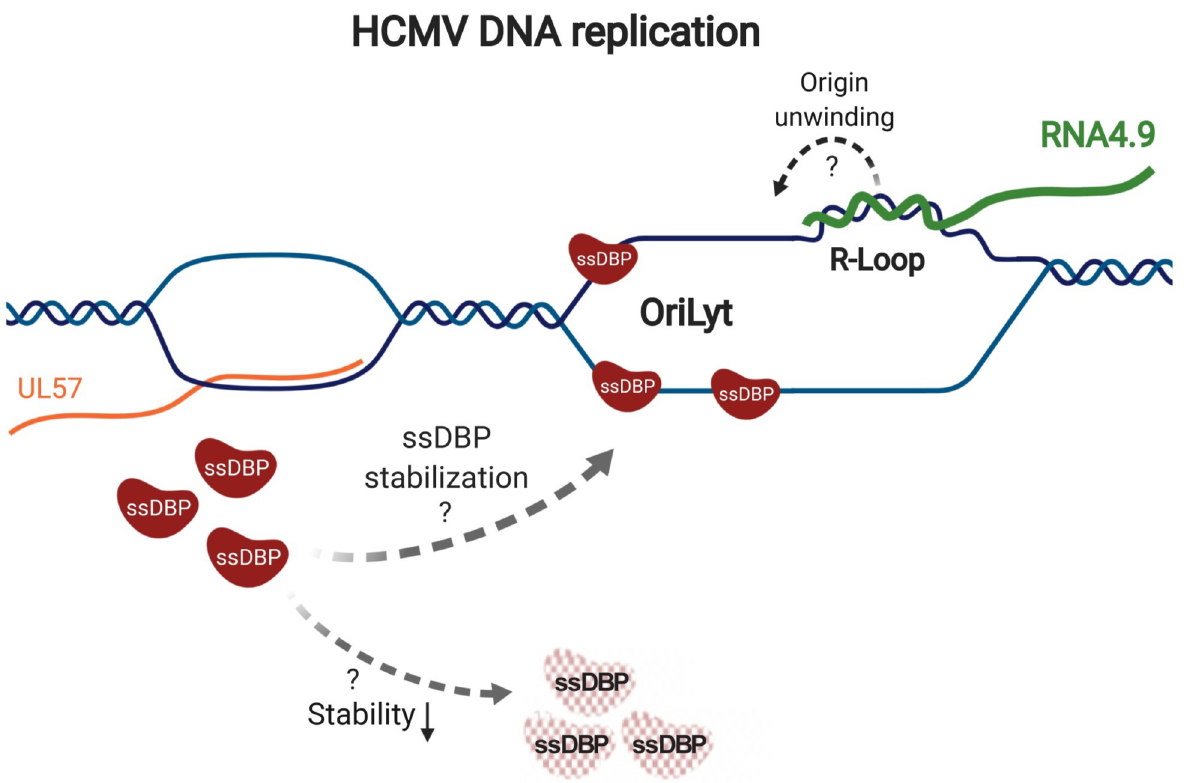
Fig 9. Proposed model for the regulation of oriLyt activity. Transcription of RNA4.9 regulates the activity of oriLyt, possibly through R-loop formation at the G+C-rich 5’ end of RNA4.9, which may initiate the oriLyt unwinding. The levels of the ssDBP are coupled to the activity of oriLyt probably through stabilization of the protein on an unwound origin. Figure was made using